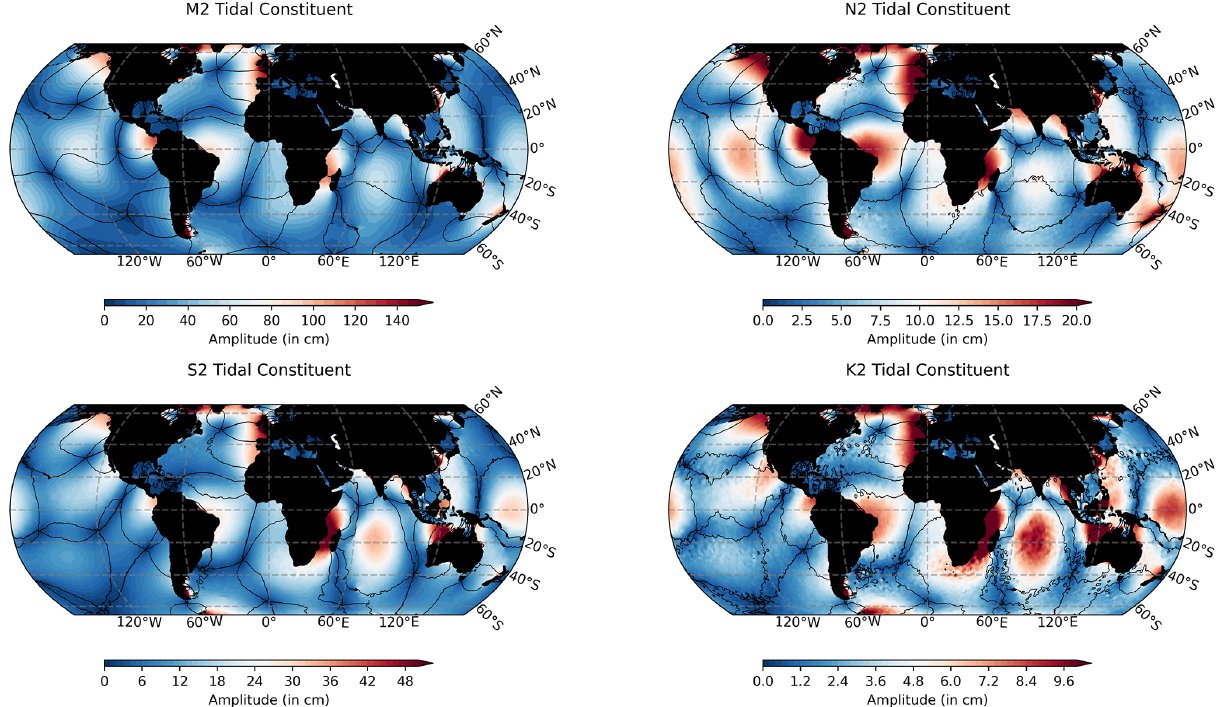
Figure 2. The amplitude (in cm) and the phase (in 60 ◦ increments) of four ocean tidal constituents produced by the EOT20 model.